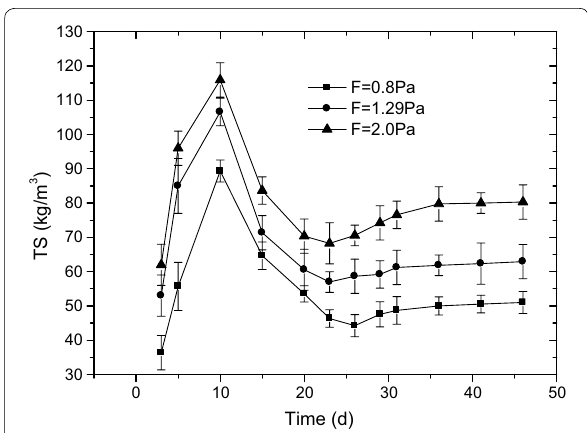
Fig. 3 Variation of biomass density at different wall-shear stresses; COD 400 mg/L (F means wall-shear stress, Pa). At three wall-shear = stresses of 0.8, 1.29 and 2.0 Pa, the average biofilm densities were 51 3, 62 5 and 80 5 kg/m 3 , respectively, indicating that the ± ± ± average biofilm densities increased with the increase of wall-shear stress